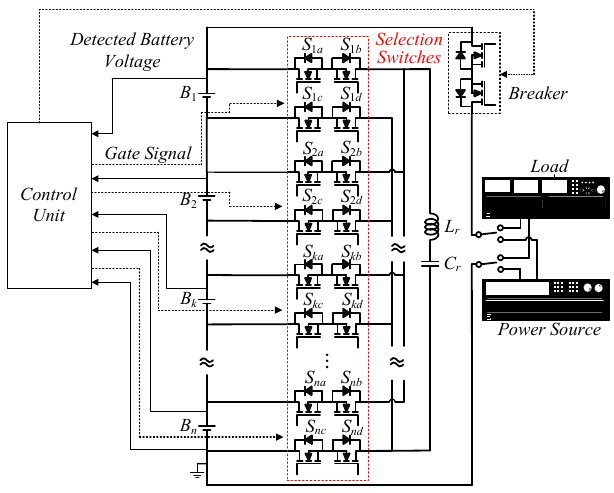
Figure 2. The proposed charge-equalization circuit.